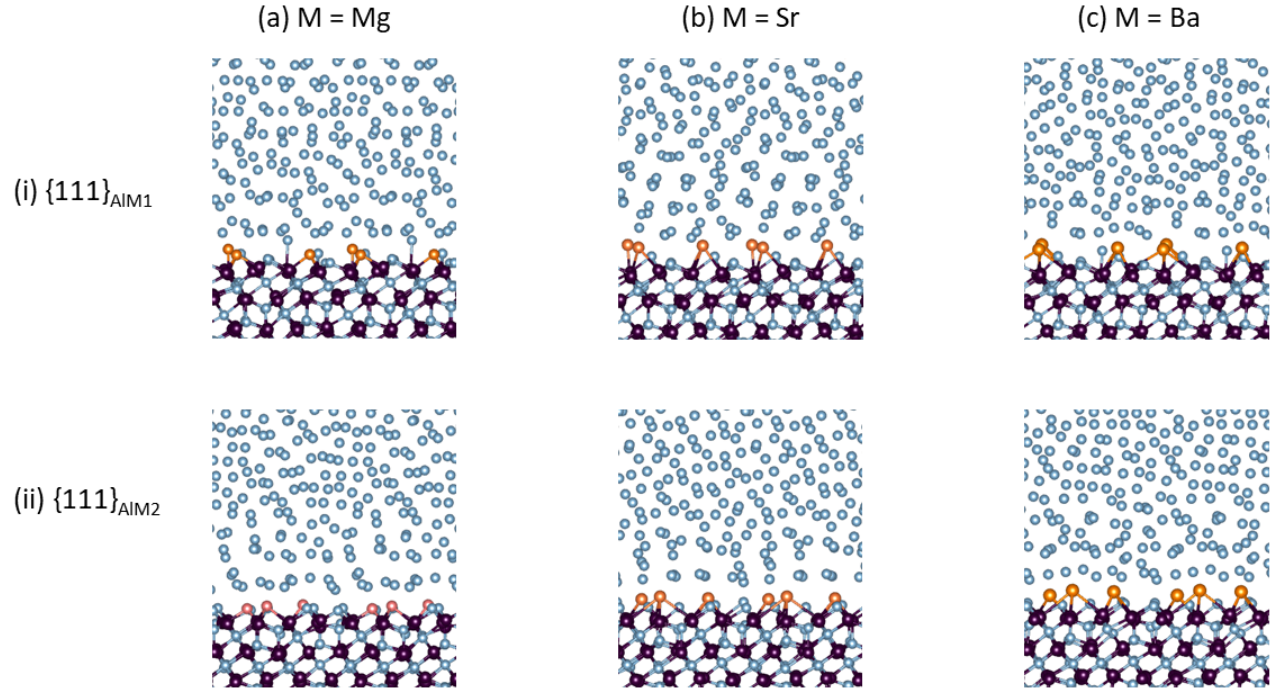
Figure 1. Snapshots of the equilibrated L-Al/ γ -Al 2 O 3 {1 1 1} AlAE interfaces. ( a ) L-Al/ γ -Al 2 O 3 {1 1 1} AlMg , ( b ) L-Al/ γ -Al 2 O 3 {1 1 1} AlSr , and ( c ) L-Al/ γ -Al 2 O 3 {1 1 1} AlBa . Row ( i ) is for S1- and Row ( ii ) for S2- interfaces. The interatomic bonds between the metal atoms and the oxygen atoms in the substrates and at the substrate surfaces are displayed. The silvery spheres represent Al, dark brown spheres represent O, and the gold spheres represent the AE atoms.